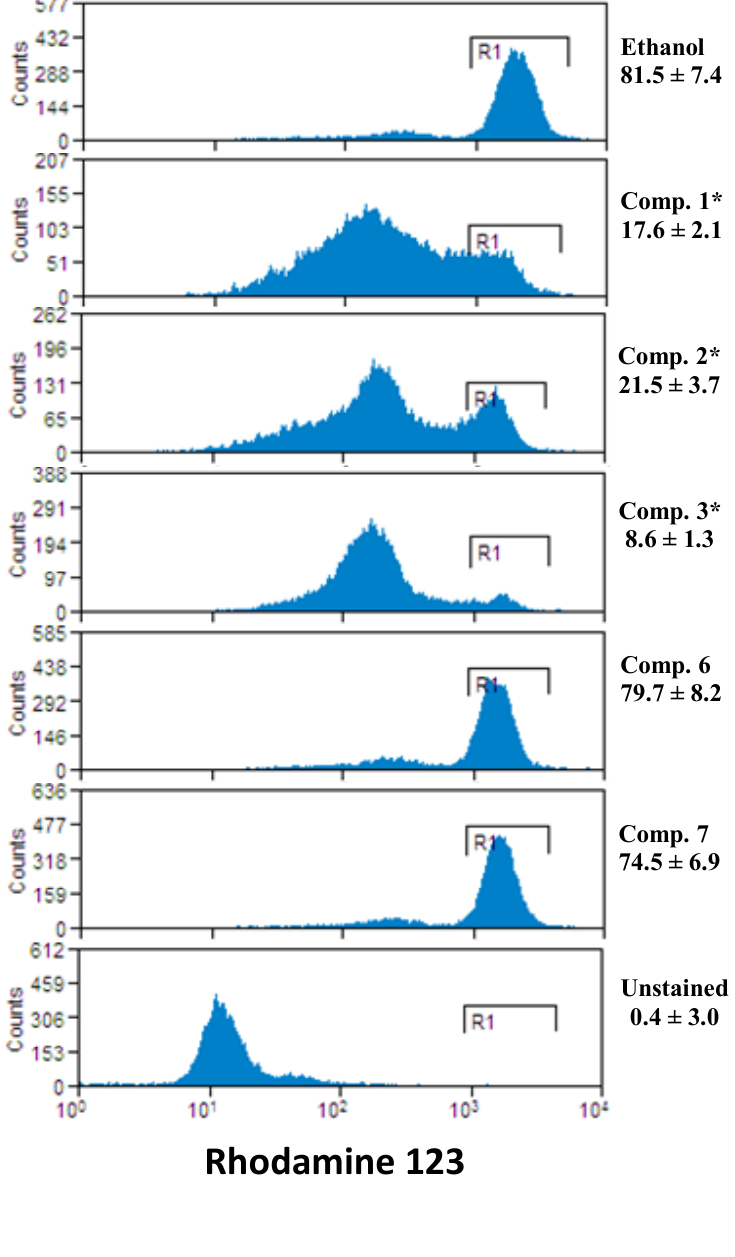
caspase 3 is decreased nearly to control cells (black or light gray columns) indicating that the effects of compounds 1–3 is specific on caspase activity. Figure 4. Ent- labdanes treatment induced changes of mitochondrial membrane permeability in MDA-MB 231 . The cells were stained with rhodamine 123, and then analyzed with flow cytometry. Representative histogram is showing changes of mitochondrial membrane permeability in MDA-MB 231 cells. Also percentage of rhodamine-123 stained cells is shown. The significance was determined by Student’s t-test (* p <